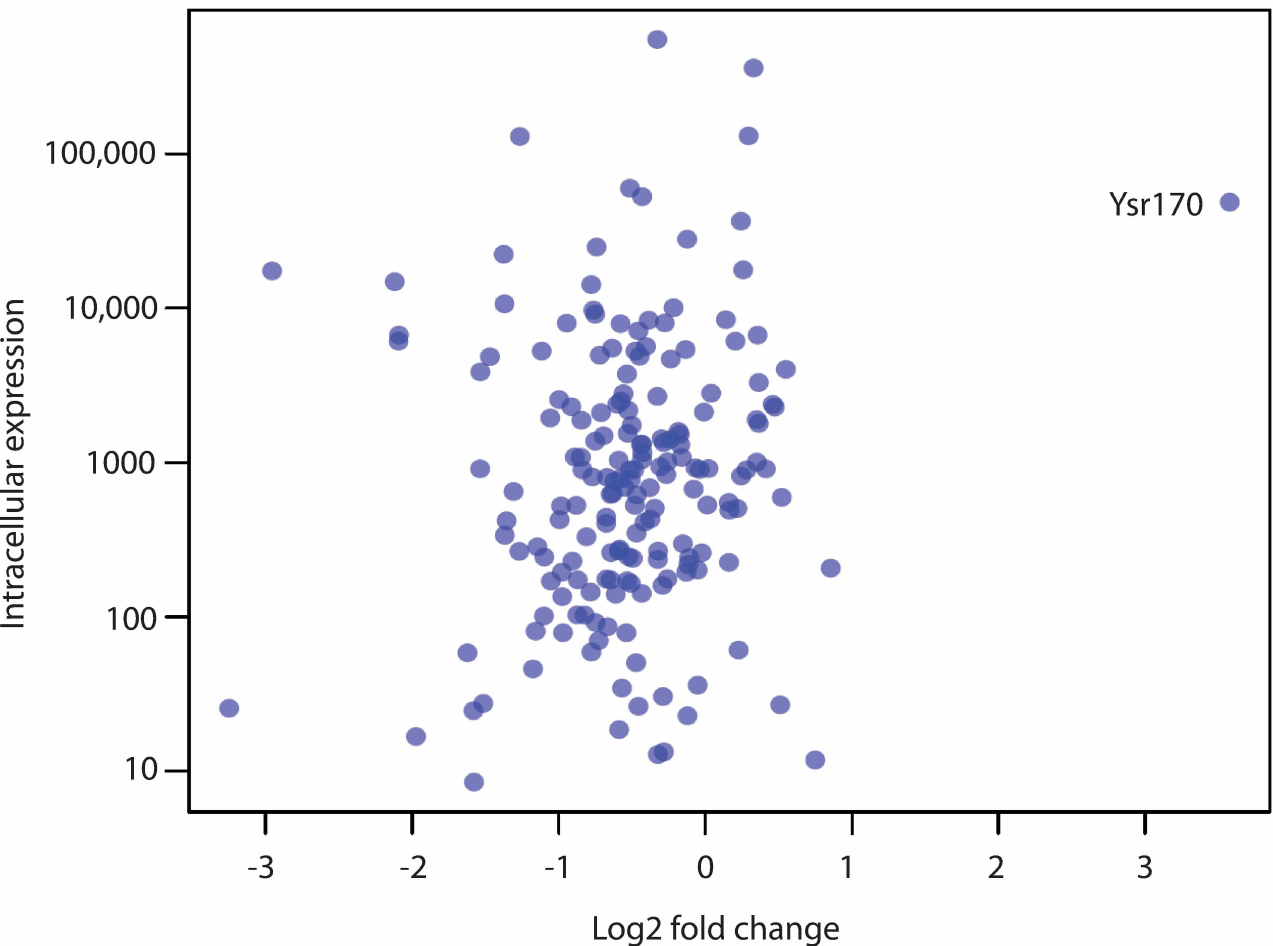
Fig 1. Comparison of the log2 fold change from extracellular to intracellular Yersinia and the mean normalized counts in intracellular Yersinia for all 180 small